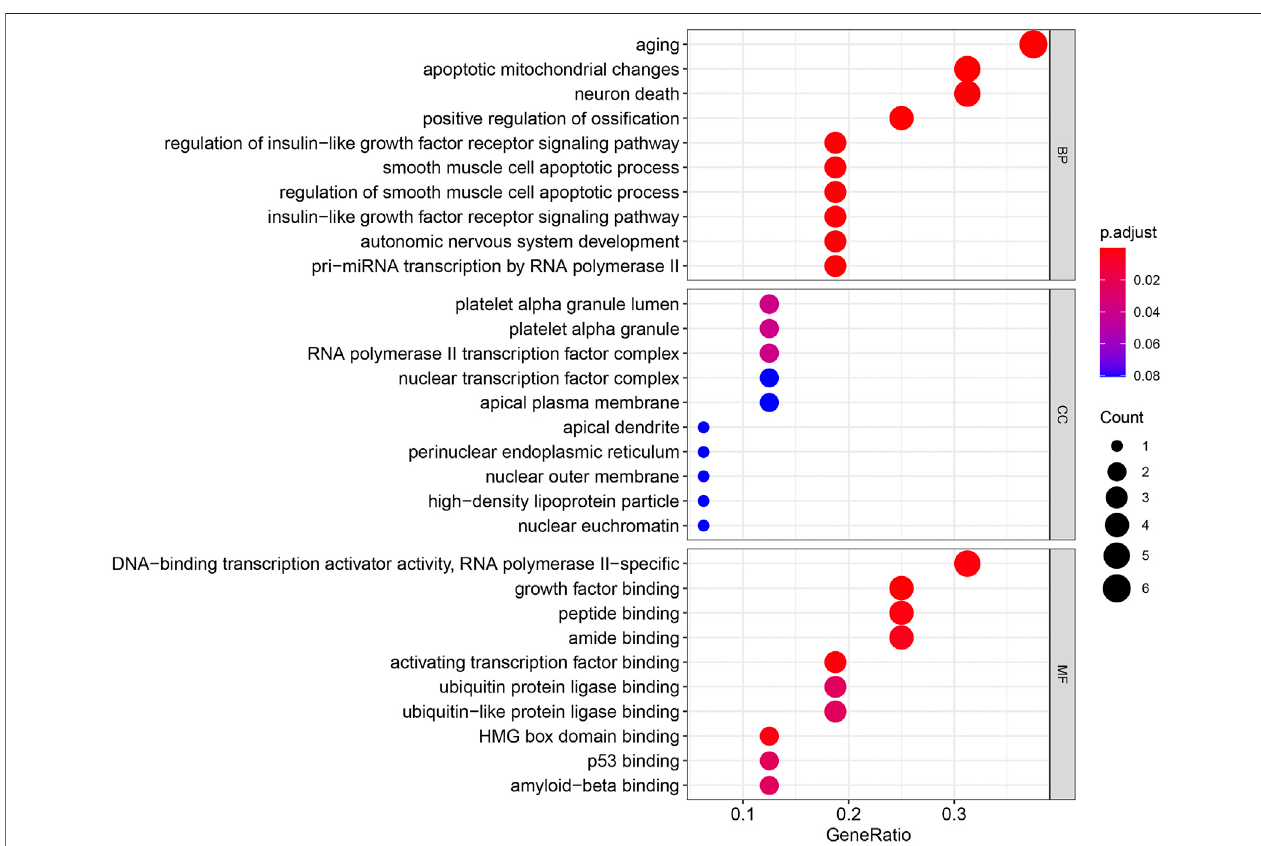
FIGURE 5 | Gene Ontology (GO) enrichment analysis of 16 differentially expressed aging-related genes. Abbreviations: BP, biological process; CC, cellular component; MF, molecular function.